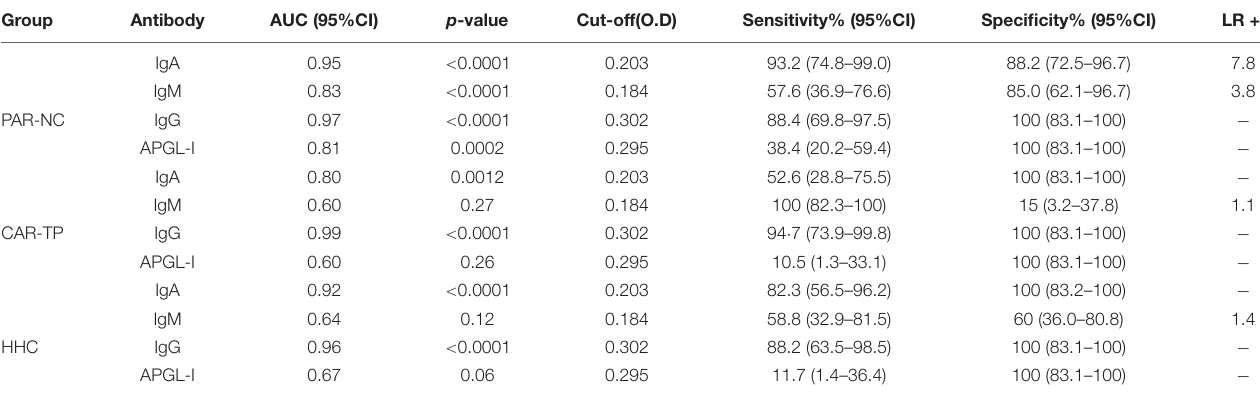
TABLE 2 | Comparison of receiver operating characteristic curve analysis for IgA, IgM, and total IgG against Mce1A protein and IgM anti-PGL-I in discriminating among new HD patients, treated HD patients and HHC vs. endemic controls. Group